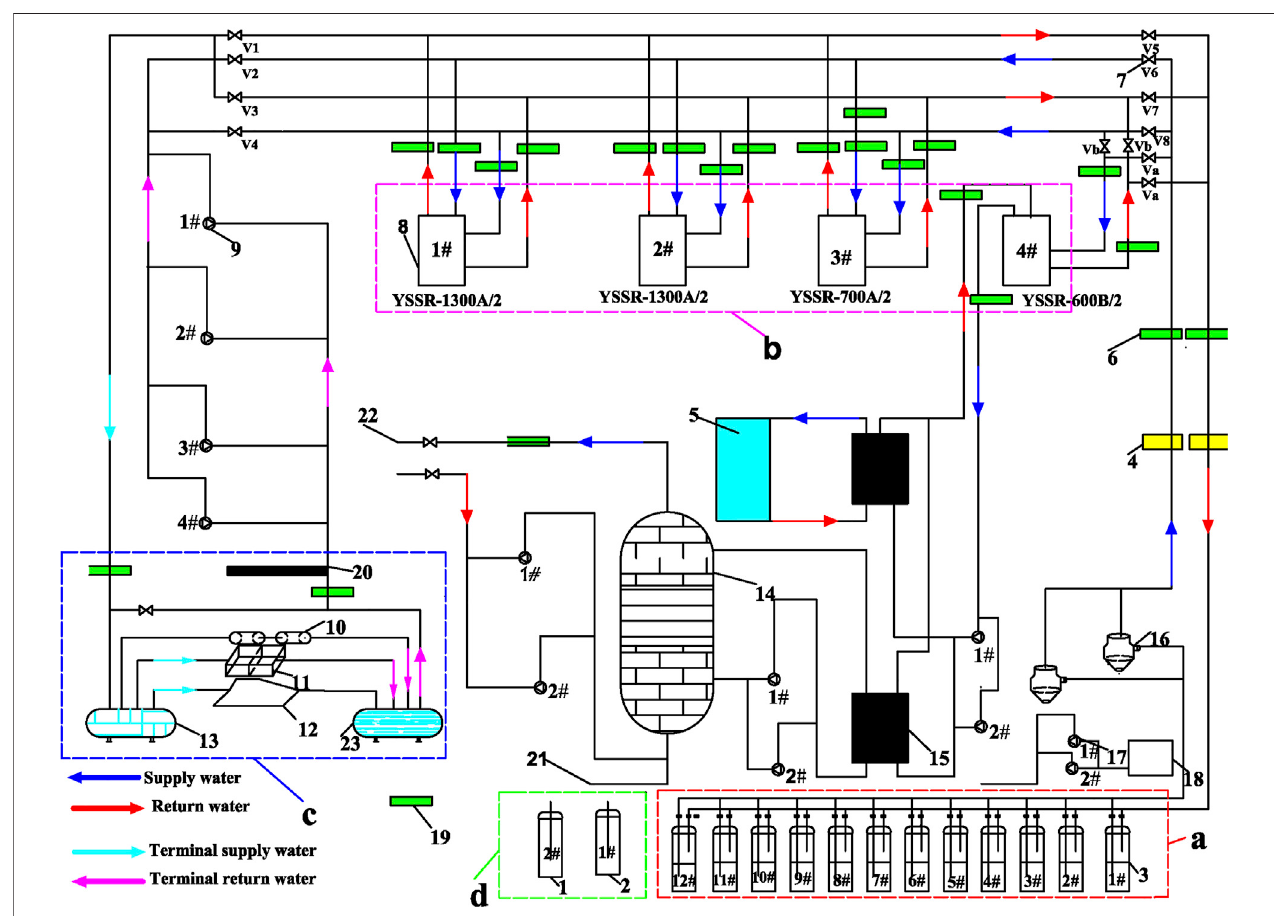
FIGURE 2 | Monitoring schematic for SWC coupled GWHP